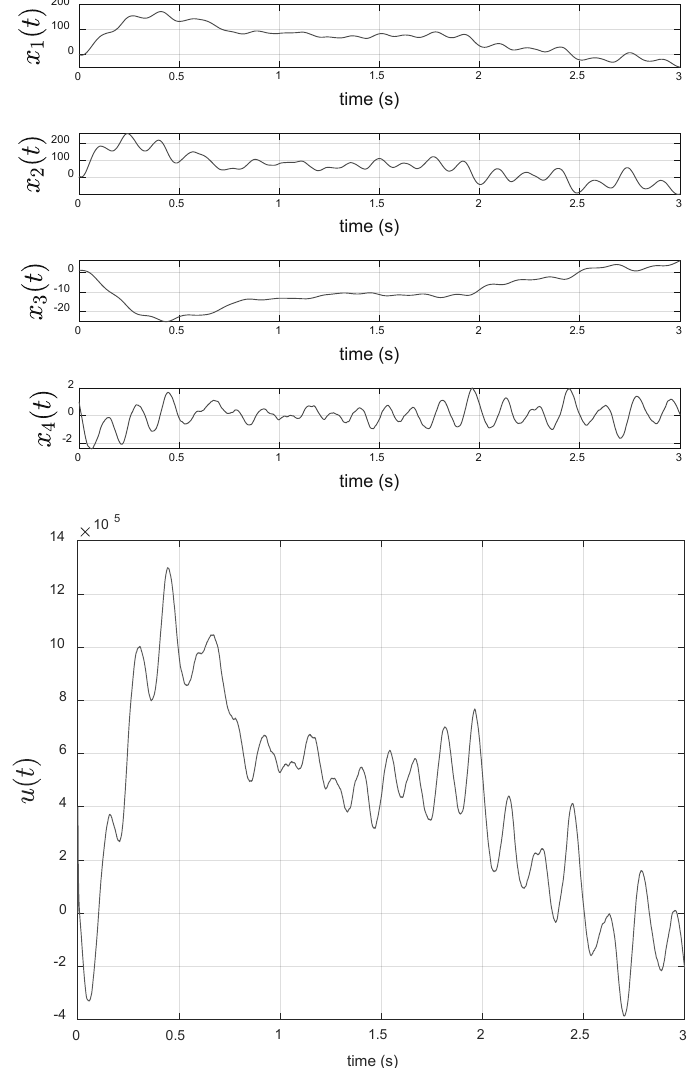
Figure 5. Asymptotic behavior of the state of dynamic system ( top ) and optimal control ( bottom